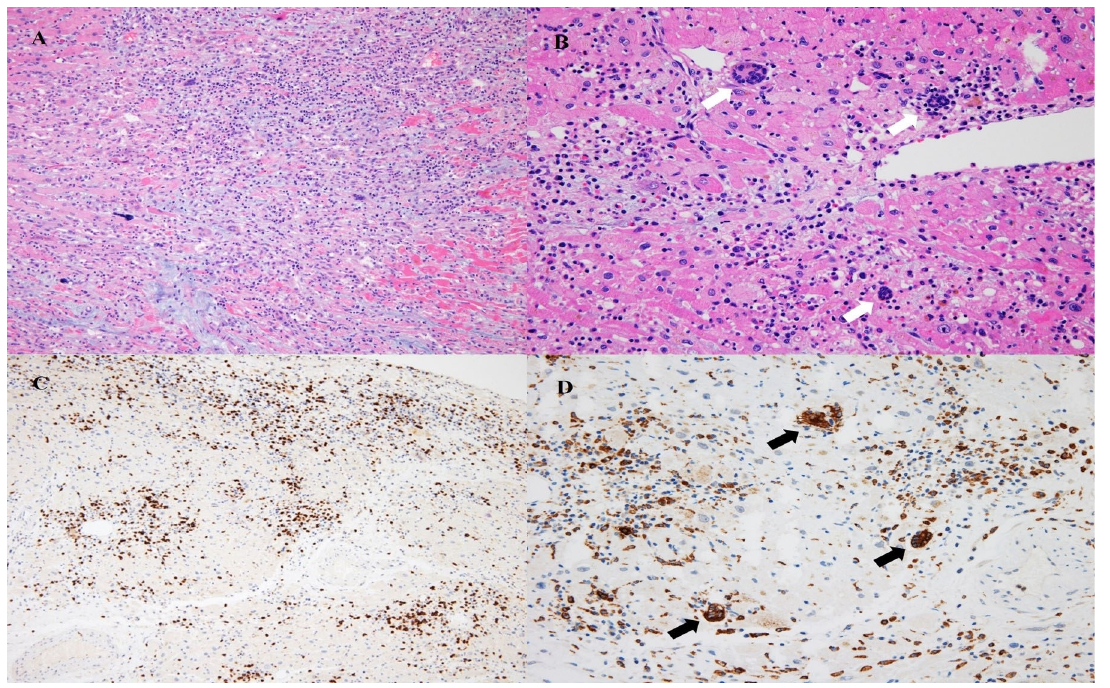
Figure 2. Pathologic findings of the heart. Diffuse cardiomyocyte necrosis and mixed inflammatory infiltration are noted ( A ; H&E, × 100). Mixed inflammation including lymphocytes, macrophages, and frequent eosinophils are noted, and multinucleated giant cells are also noted ( B ; H&E, × 200). T- lymphocytic infiltration is identified ( C ; CD3, × 100). Infiltration of CD68+ macrophages is identified, and multinucleated giant cells are positive for CD68 ( D ; CD68, × 200). Black and white arrows show multinucleated giant